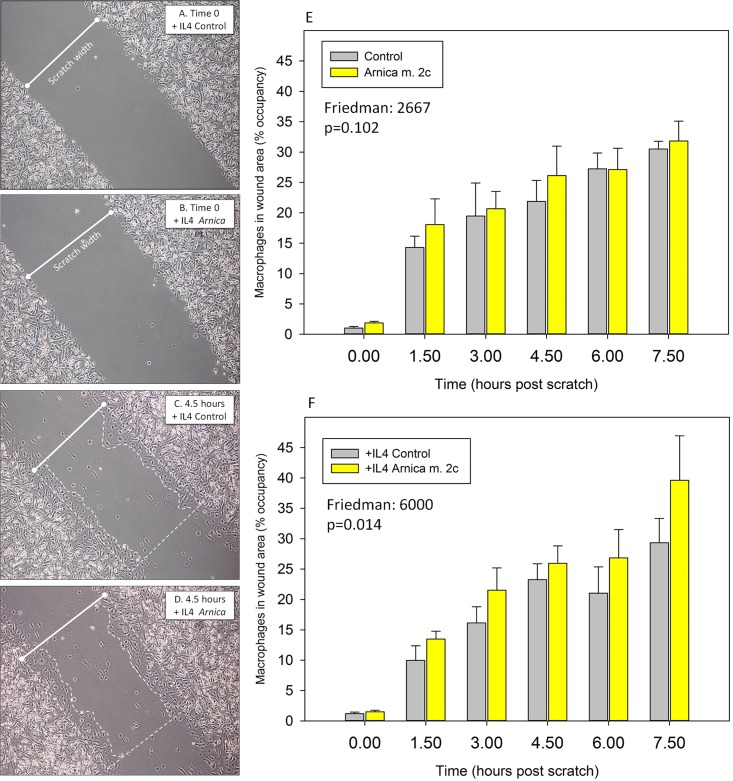
Wound closure effect of Arnica m.Light microscope images of in vitro wound closure using a confluent monolayer of BMD macrophages. The microphotographs show one representative experiment of cell migration into the created wound area in the absence (A and C) and in the presence (B and D) of Arnica m. 2c. Images A and B show the wound area immediately after scratching, while C and D show the wound area after 4.5 h. Pictures were acquired by means of contrast phase microscopy with 100x original magnification. The bar charts (E and F) report the gap width of the wound area before and after cell migration. E and F: Time-course of wound occupancy in the absence (E) and in the presence (F) of 20 ng/ml IL-4. Gray bars: Control solvent, yellow bars: Arnica m. 2c. Means±SE of three replicate wells of an experiment representative of the three performed. The result of the Friedman test comparing the whole series of changes in cells treated with drug or with Control solvent is reported in the graph panels.